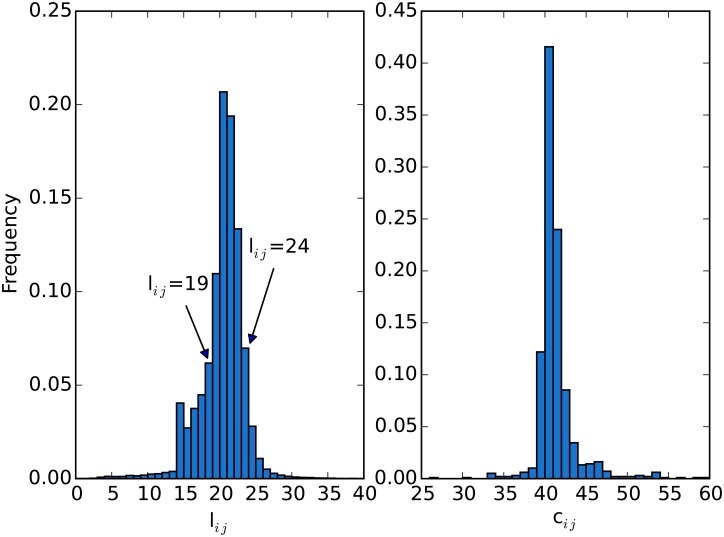
The distributions of flow distance (lij) and symmetric distance (cij).